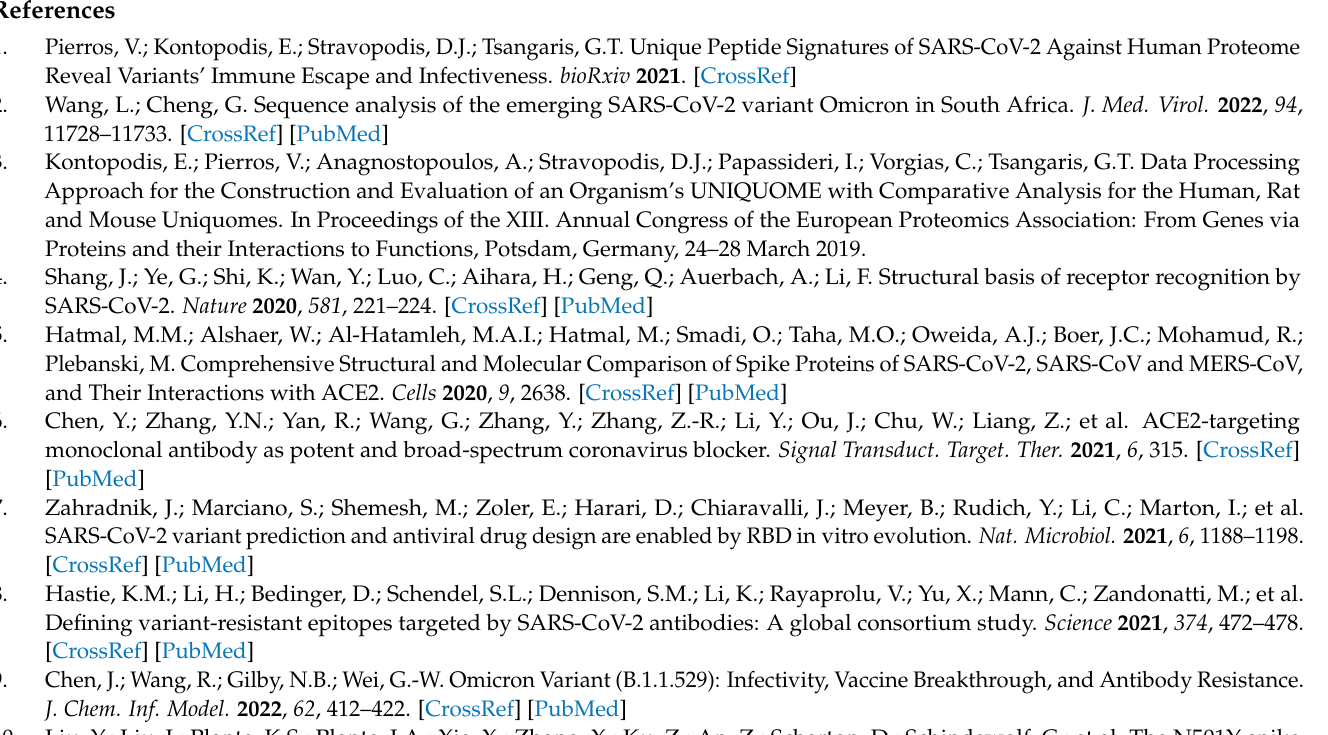
Figure S2: Extracting CrUPs of Target vs Reference Proteome; Figure S3: Alignment of the SARS- CoV-2 Spike protein (SPIKE_SARS2, P0DTC2) of the 26 variants, together with the wild-type Spike Protein (SPIKE_SARS2, P0DTC2); Figure S4: Length distribution of Omicron variant Spike protein C/H-CrUPs; Table S1: New C/H-CrUPs located in the RBD and RBM regions of the Spike protein across virus